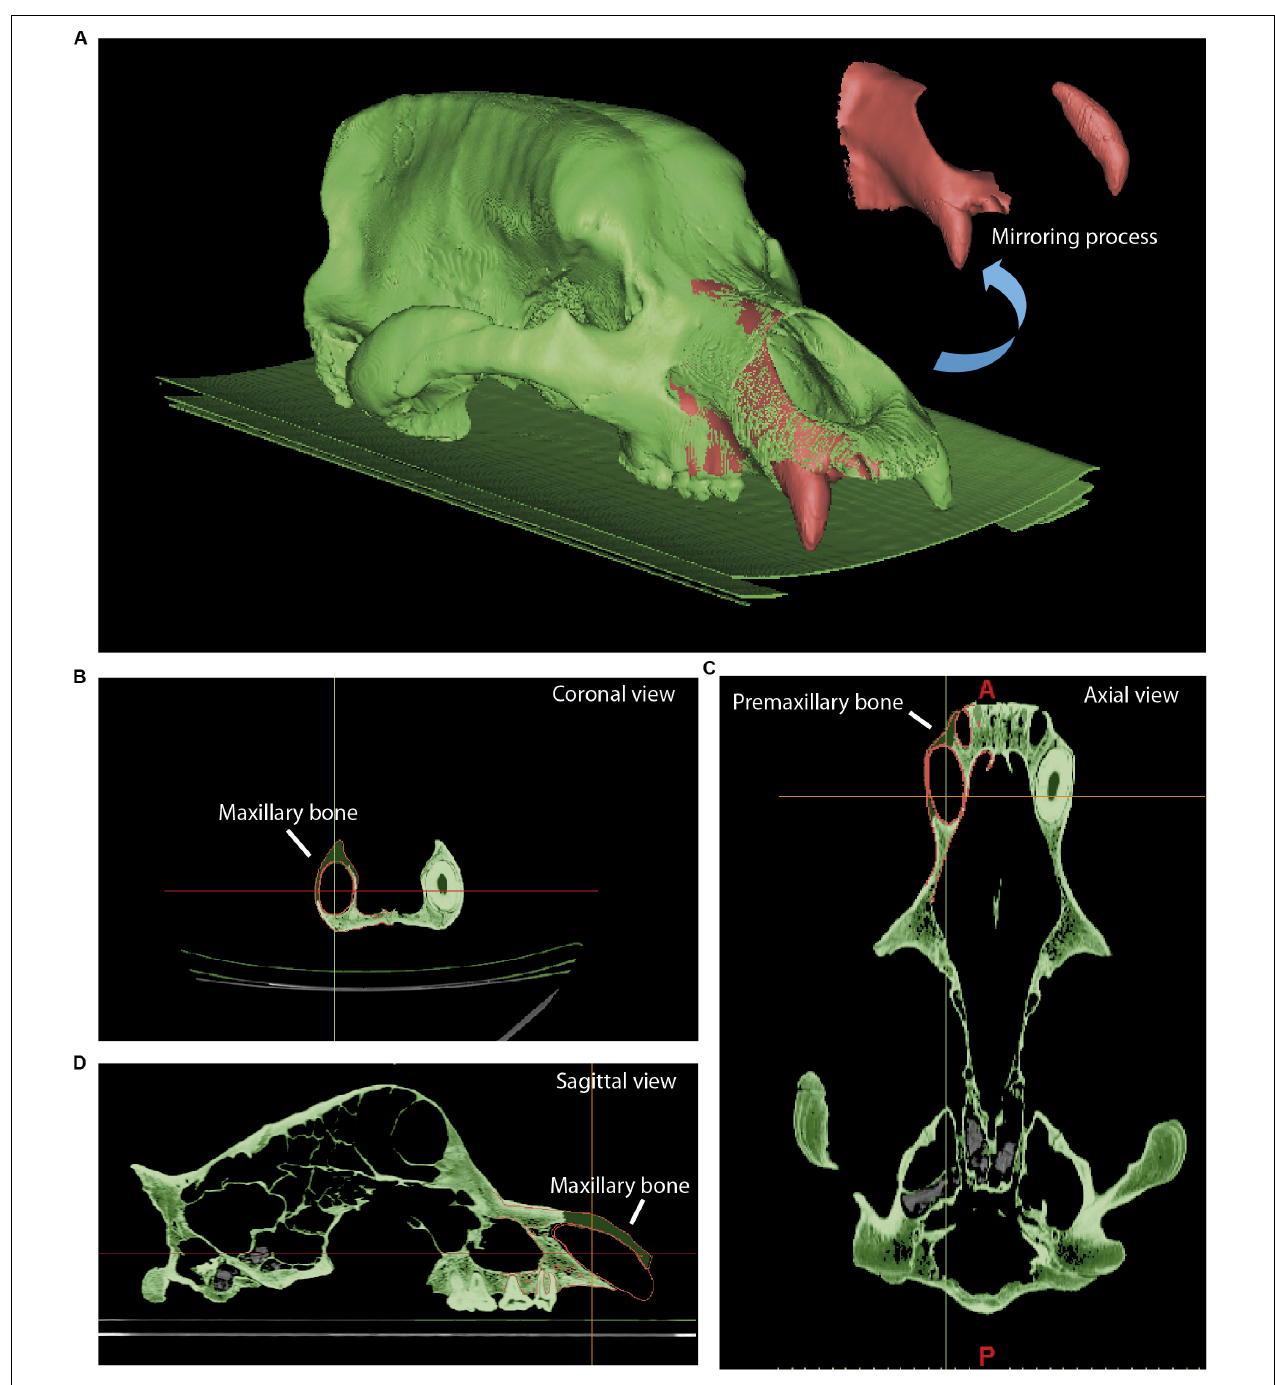
FIGURE 6 | Reconstruction of the skull using the mirroring process, illustrated with the digital rendering of Ursus ingressus (PIUW3000/5/105). (A) The 3D virtual model skull showing the mirrored partial bone skull and the canine (in red) with the original bone in green. In (B–D) , the orthogonal views showing original bone in green and the reconstructed bone highlighted by the red polyline are